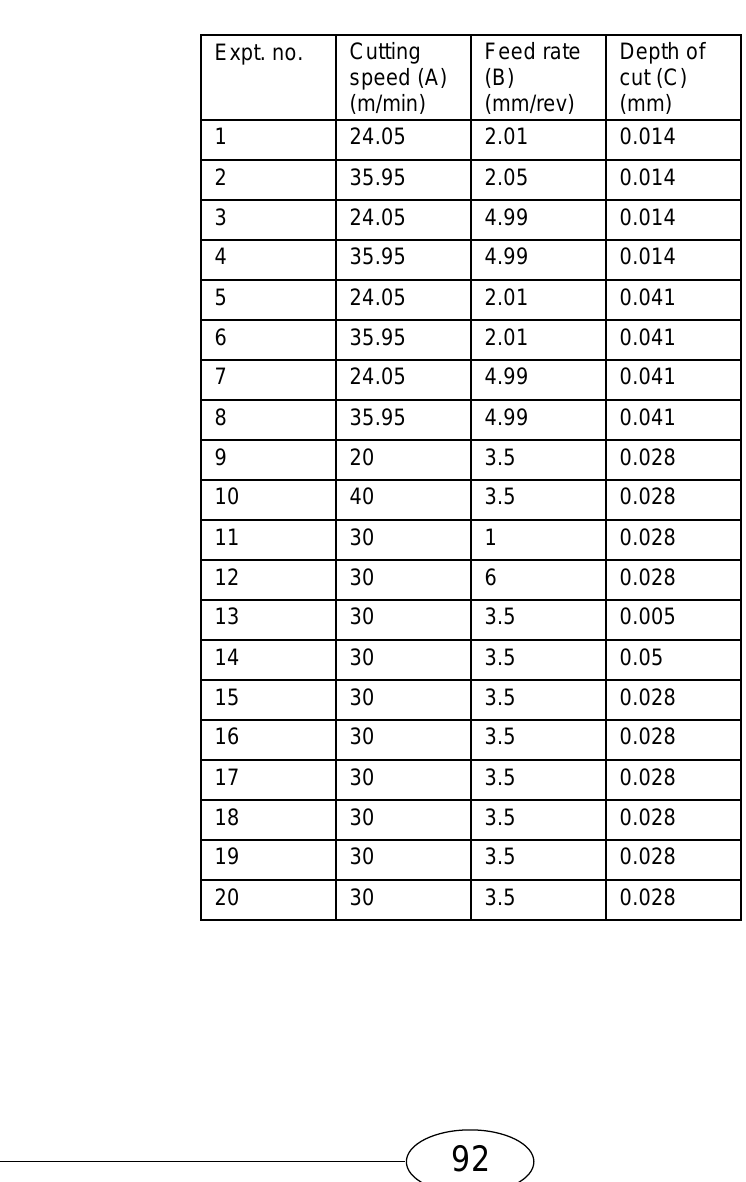
Table 4 – Response surface central composite rotatable design matrix and the test